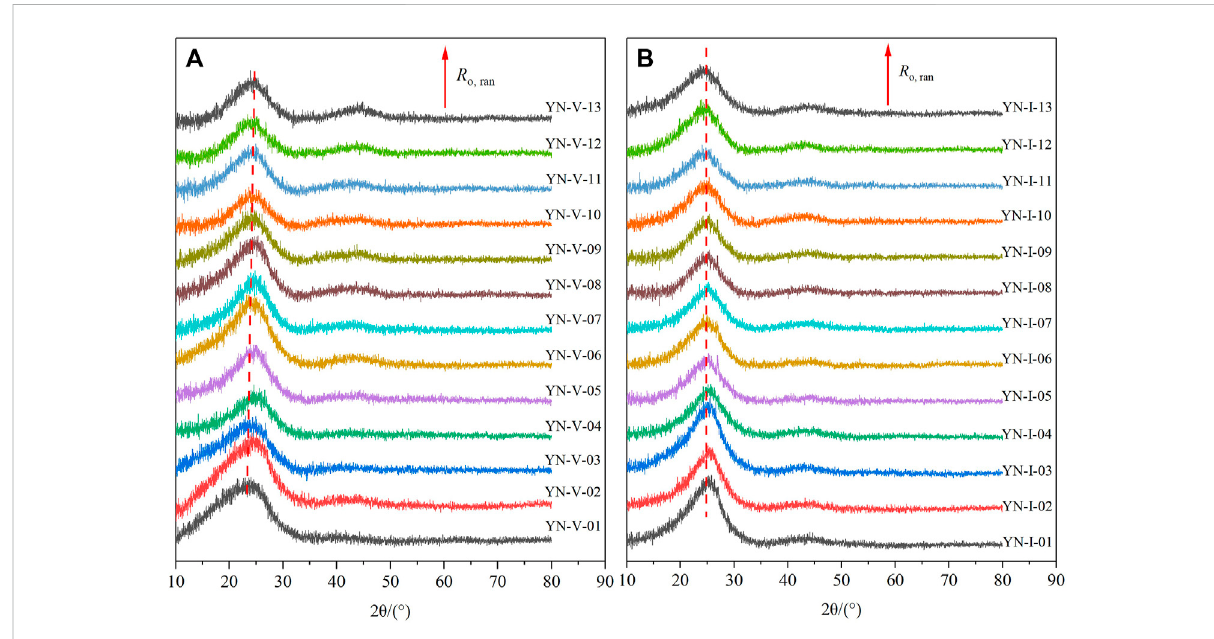
FIGURE 3 XRD spectrums of thermally simulated vitrinite (A) and inertinite (B)